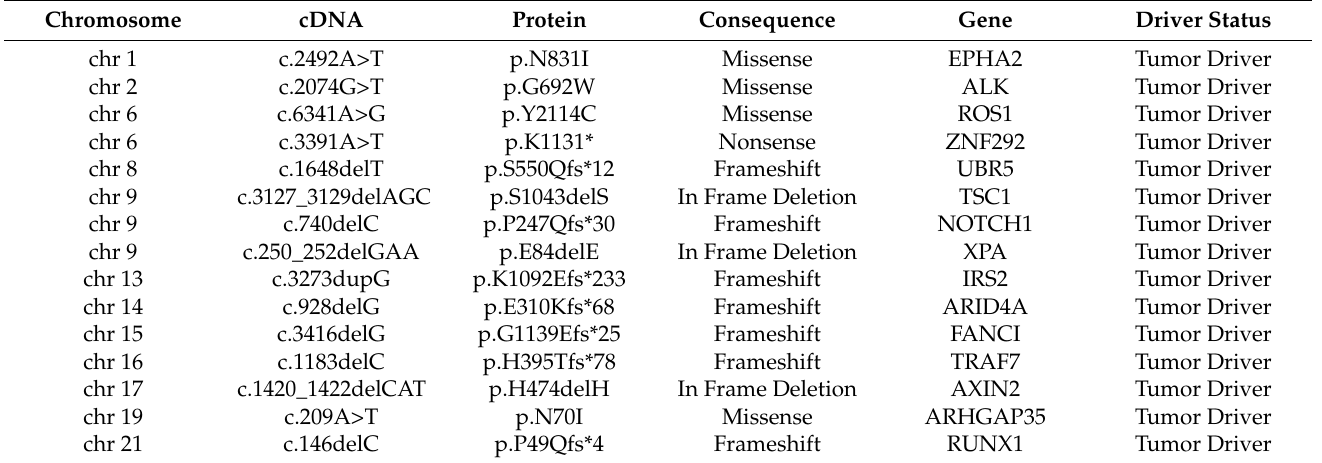
Table 2. Somatic mutations present in FaDu Resistant compared with FaDu Parental cell